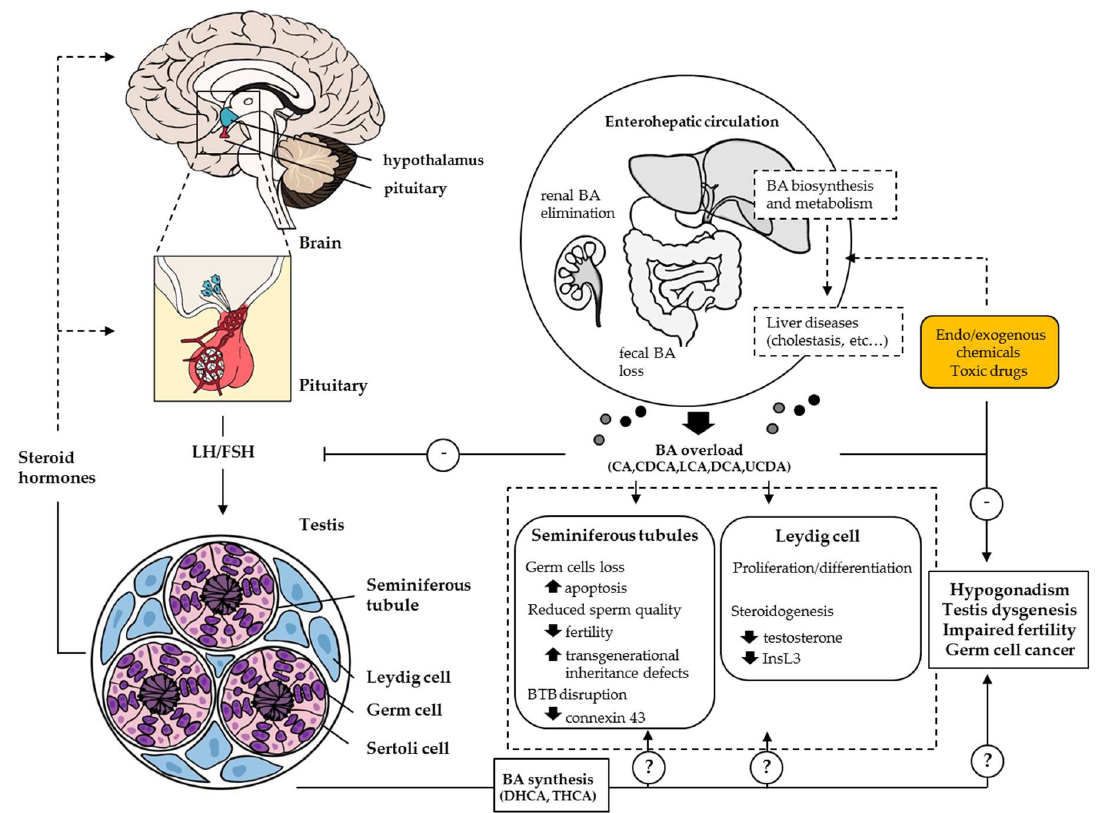
Figure 3. Overview of reproductive disorders linked to disturbance in BA homeostasis. Disturbance in BA homeostasis within the enterohepatic cycle results in hypogonadism with reduced androgens synthesis in the testis. Under normal conditions, BAs that escape the enterohepatic circulation are excreted in urine and feces, but BA overload due to impaired bile flow or xenobiotic/drug-induced liver cytotoxicity can cause a variety of fertility disorders. High BA levels reduce steroidogenesis in Leydig cells and disrupt the BTB, leading to enhanced germ cell degeneration with an impact on reproductive functions. In mouse, BA synthesis also takes place in the testis where germ cells develop from the tubule wall toward the central lumen (modified from [158,159]).